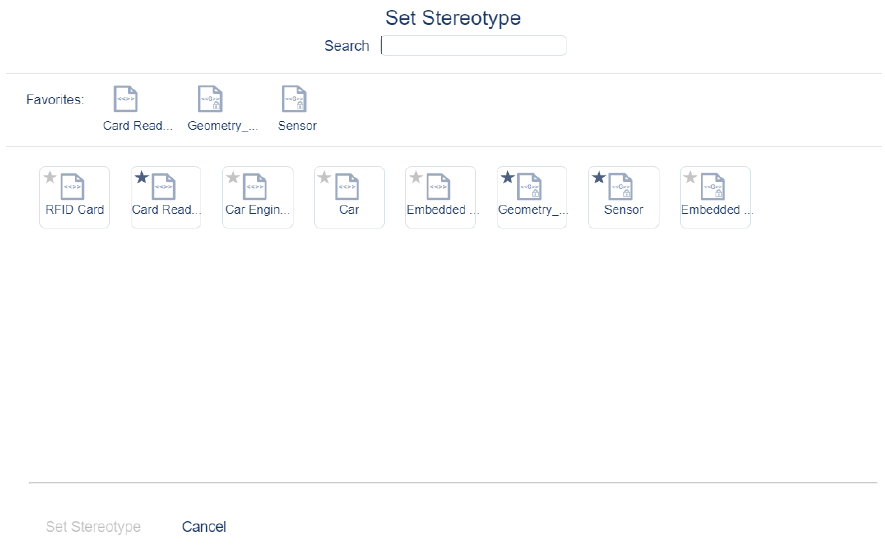
Figure 7. The Set Stereotype screen.